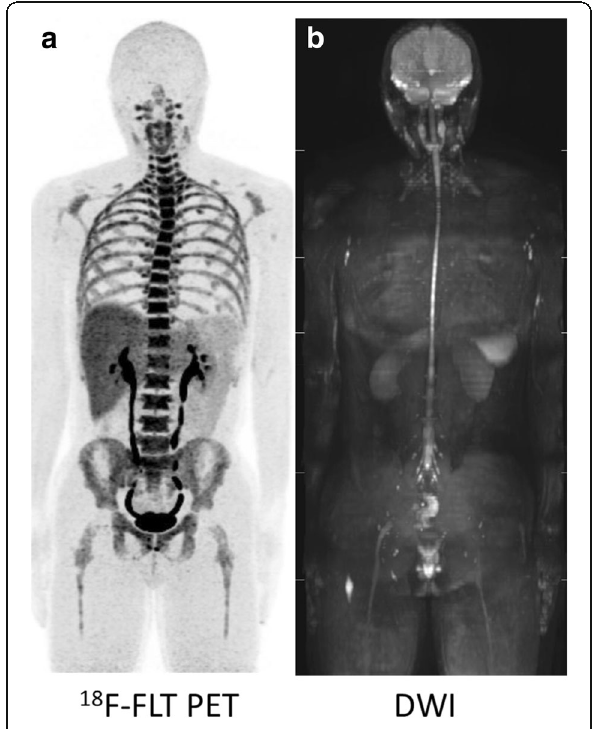
Fig. 2 Maximum intensity projection 18 F-FLT PET ( a ) and DWI ( b ) images of a healthy subject. 18 F-FLT PET clearly visualizes whole- body hematopoietic activity consistent with red bone marrow distribution ( a ). Whole-body DWI visualizes some organs, such as the spleen, kidneys, spinal cord, and lymph nodes, whereas red bone marrow is invisible or partially visible in normal subjects ( b